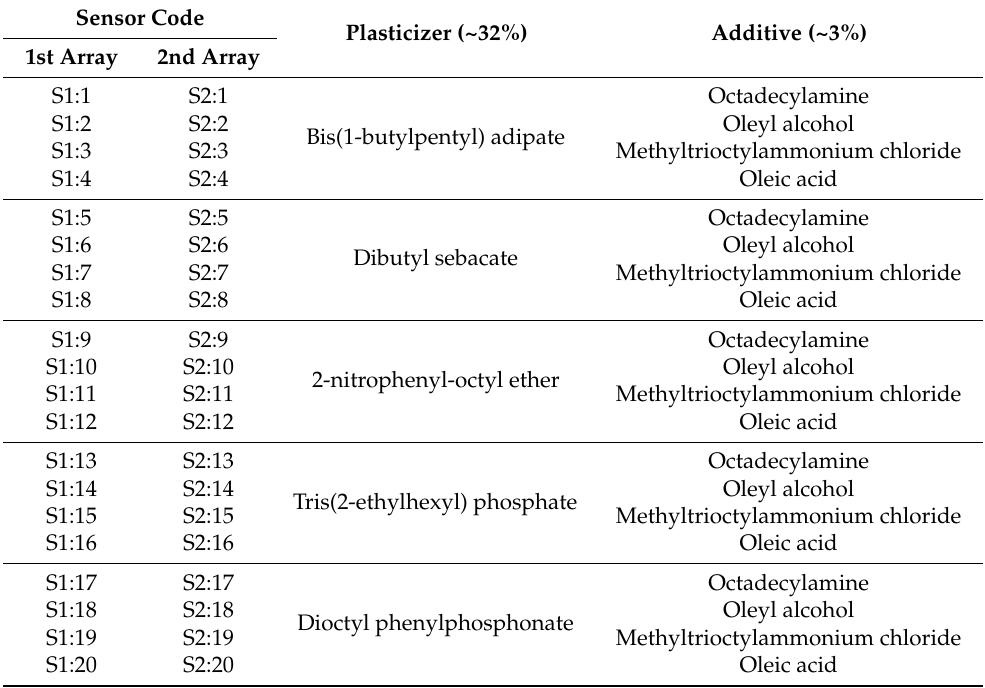
Figure 1. Lab-made E-tongue device: sensor arrays, data logger (data acquisition unit) and control software installed on a PC. Table 1. E-tongue sensor codes and related composition (%) of the respective lipid membranes (type/pair of additive and plasticizer).